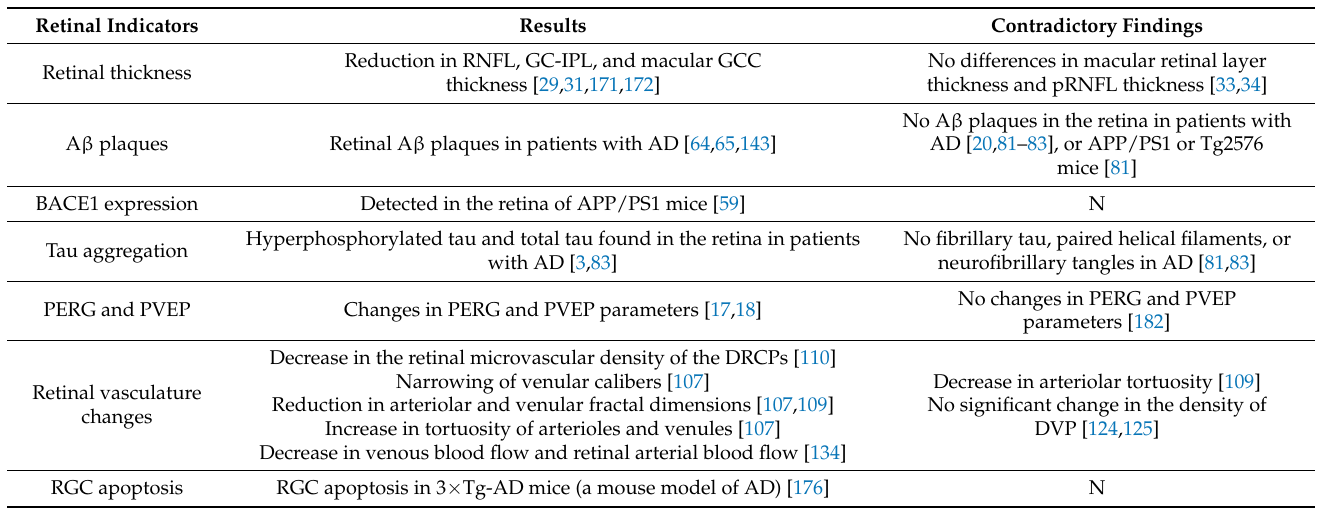
Table 5. Comparison of different studies on the retinal changes in Alzheimer’s